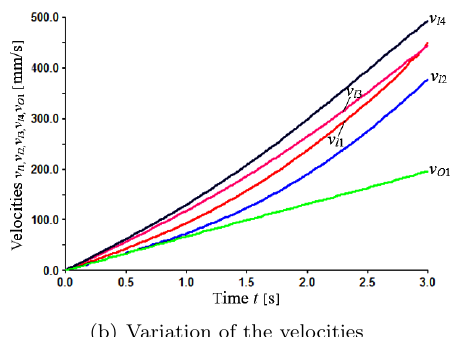
Figure 9: The slender structural part